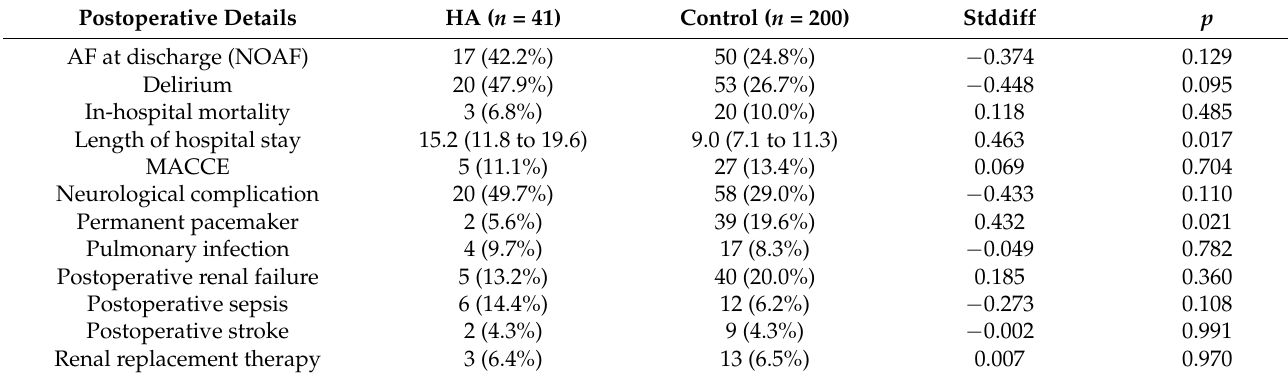
Table 4). Postoperative data before IPTW are shown Supplementary Table S5. Table 4. Postoperative outcome after inverse probability of treatment